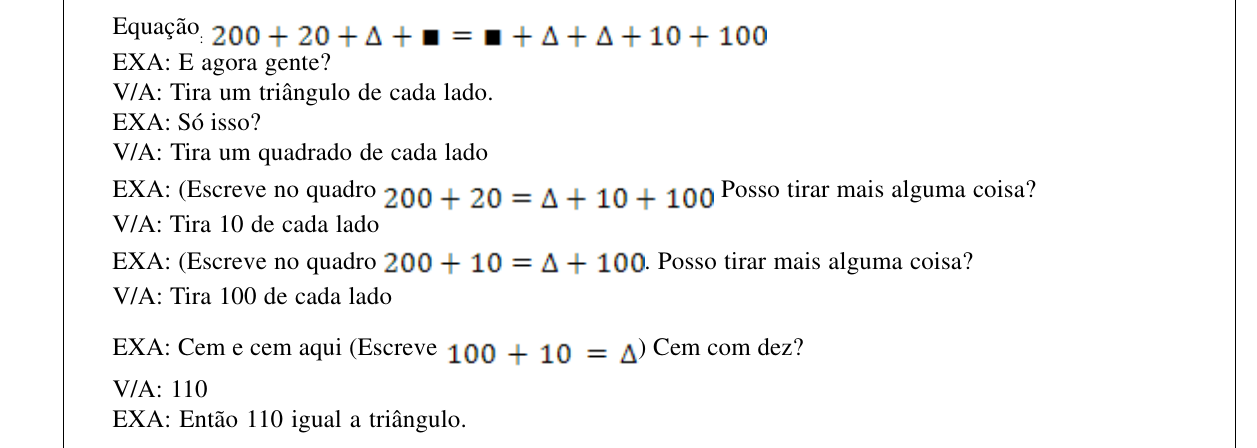
Figura 5 . Necessidade da estratégia de tirar termos iguais de ambos os membros da equação para a resolução da